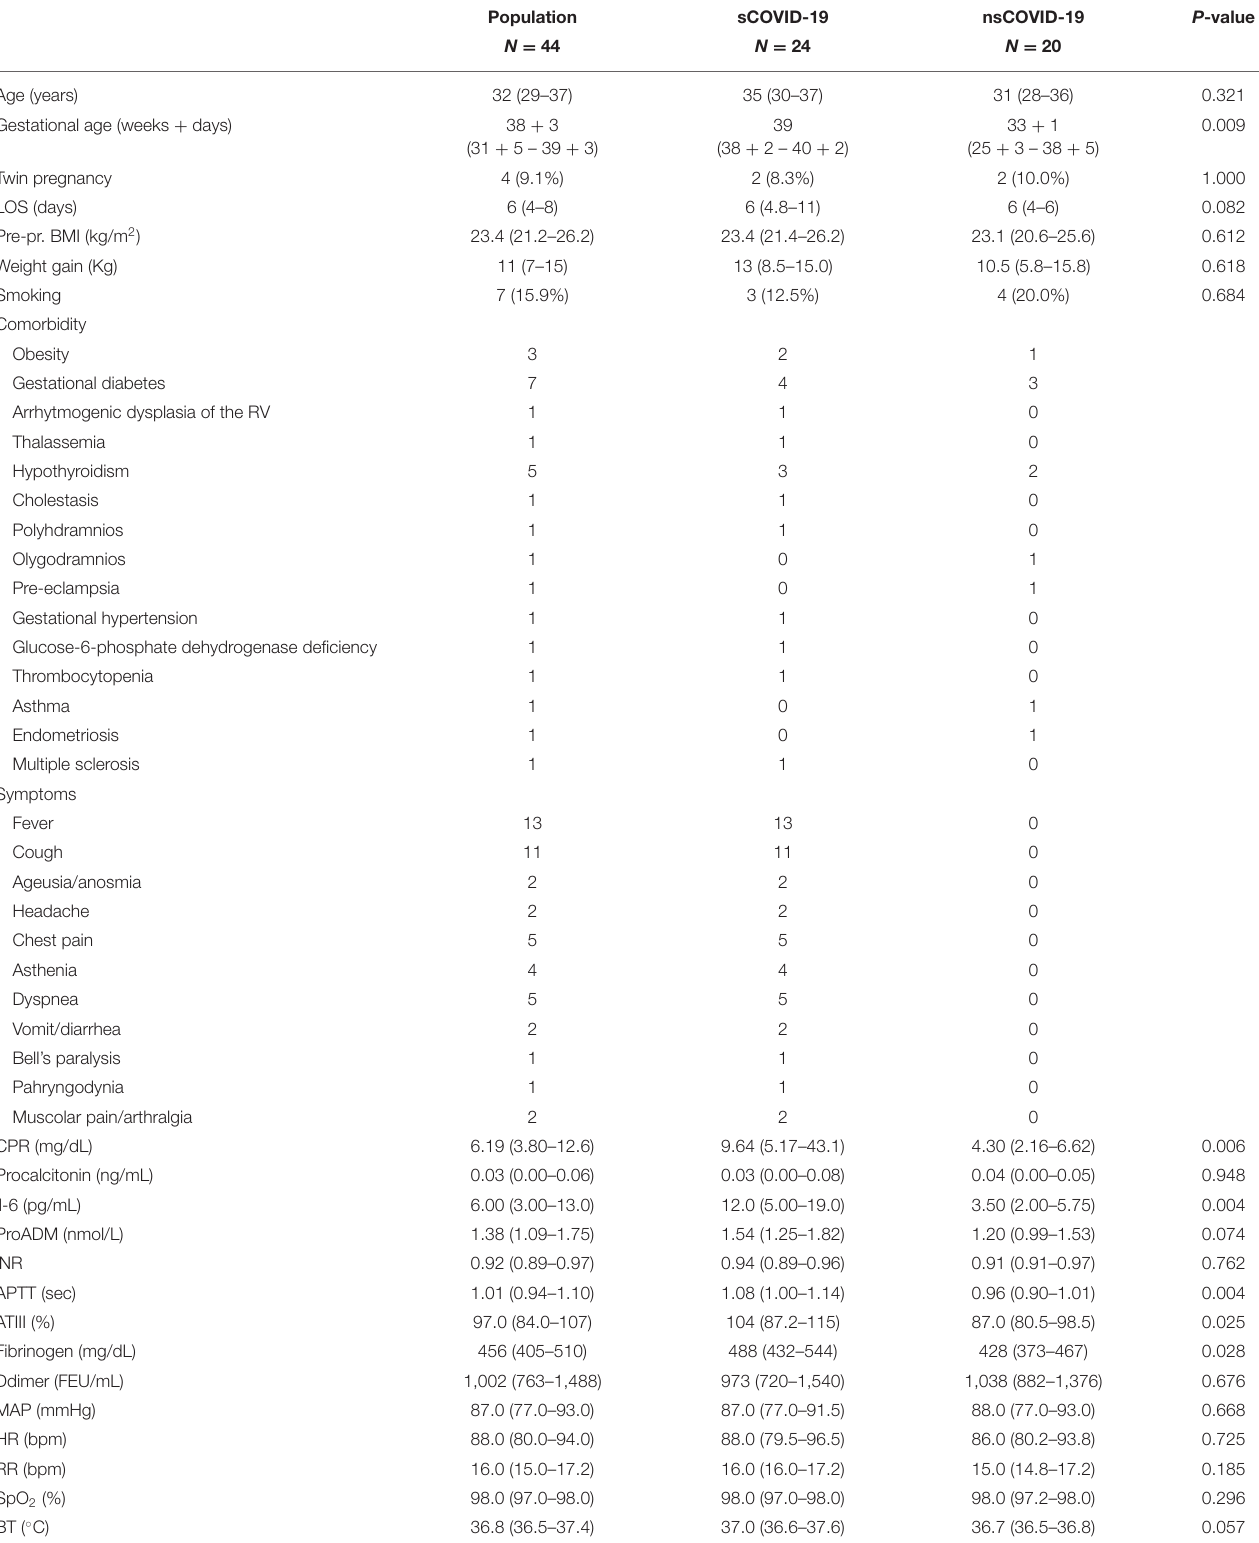
TABLE 1 | Distribution of the analysis variables in the sample and between the two groups, symptomatic (sCOVID-19) and asymptomatic (nsCOVID-19) patients with